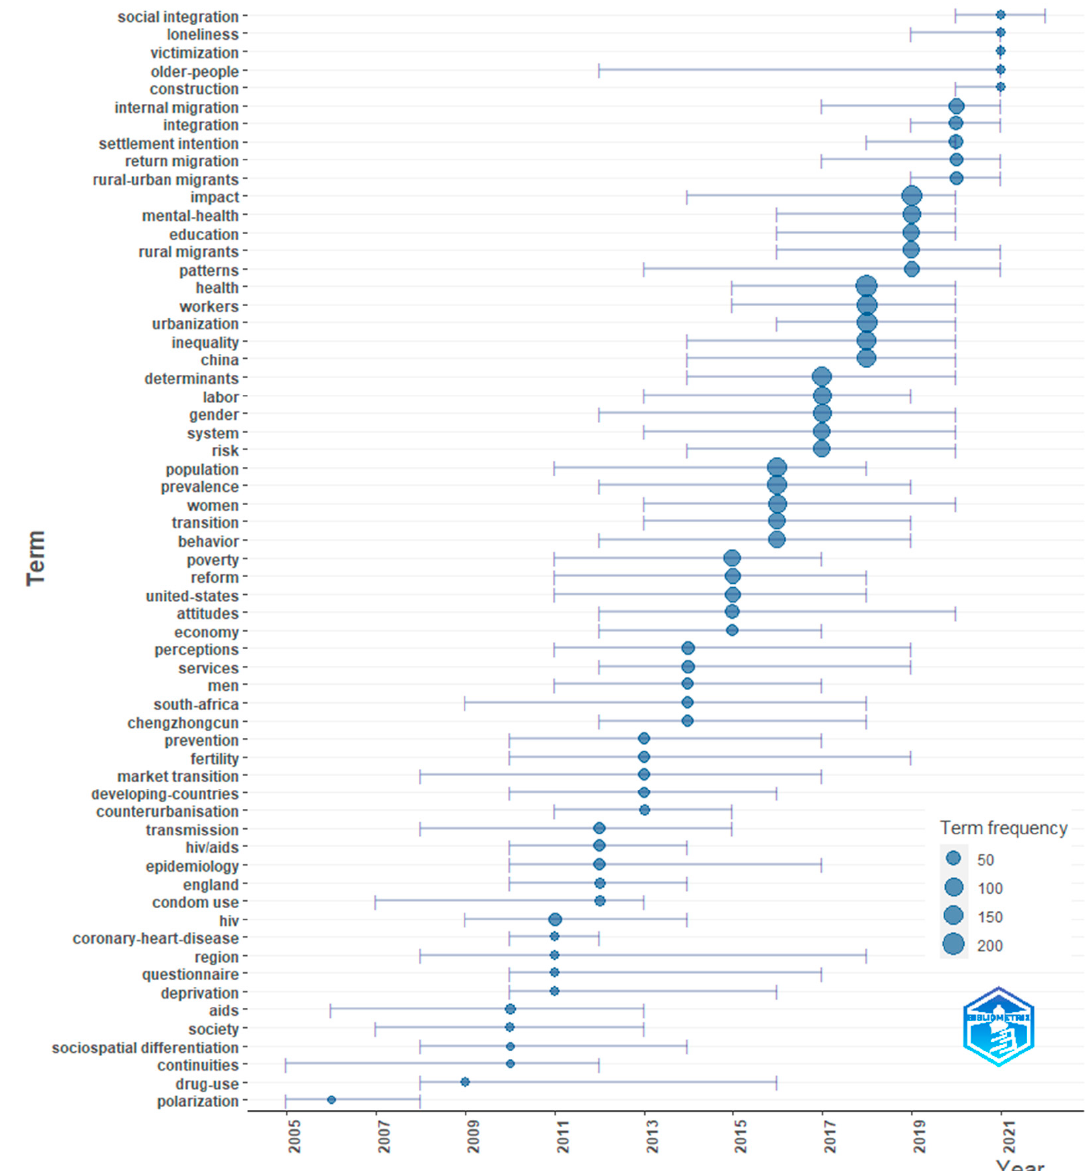
Figure 8. Trend topics of studies on rural-to-urban migrants (1 January 2004–3 June 2022).